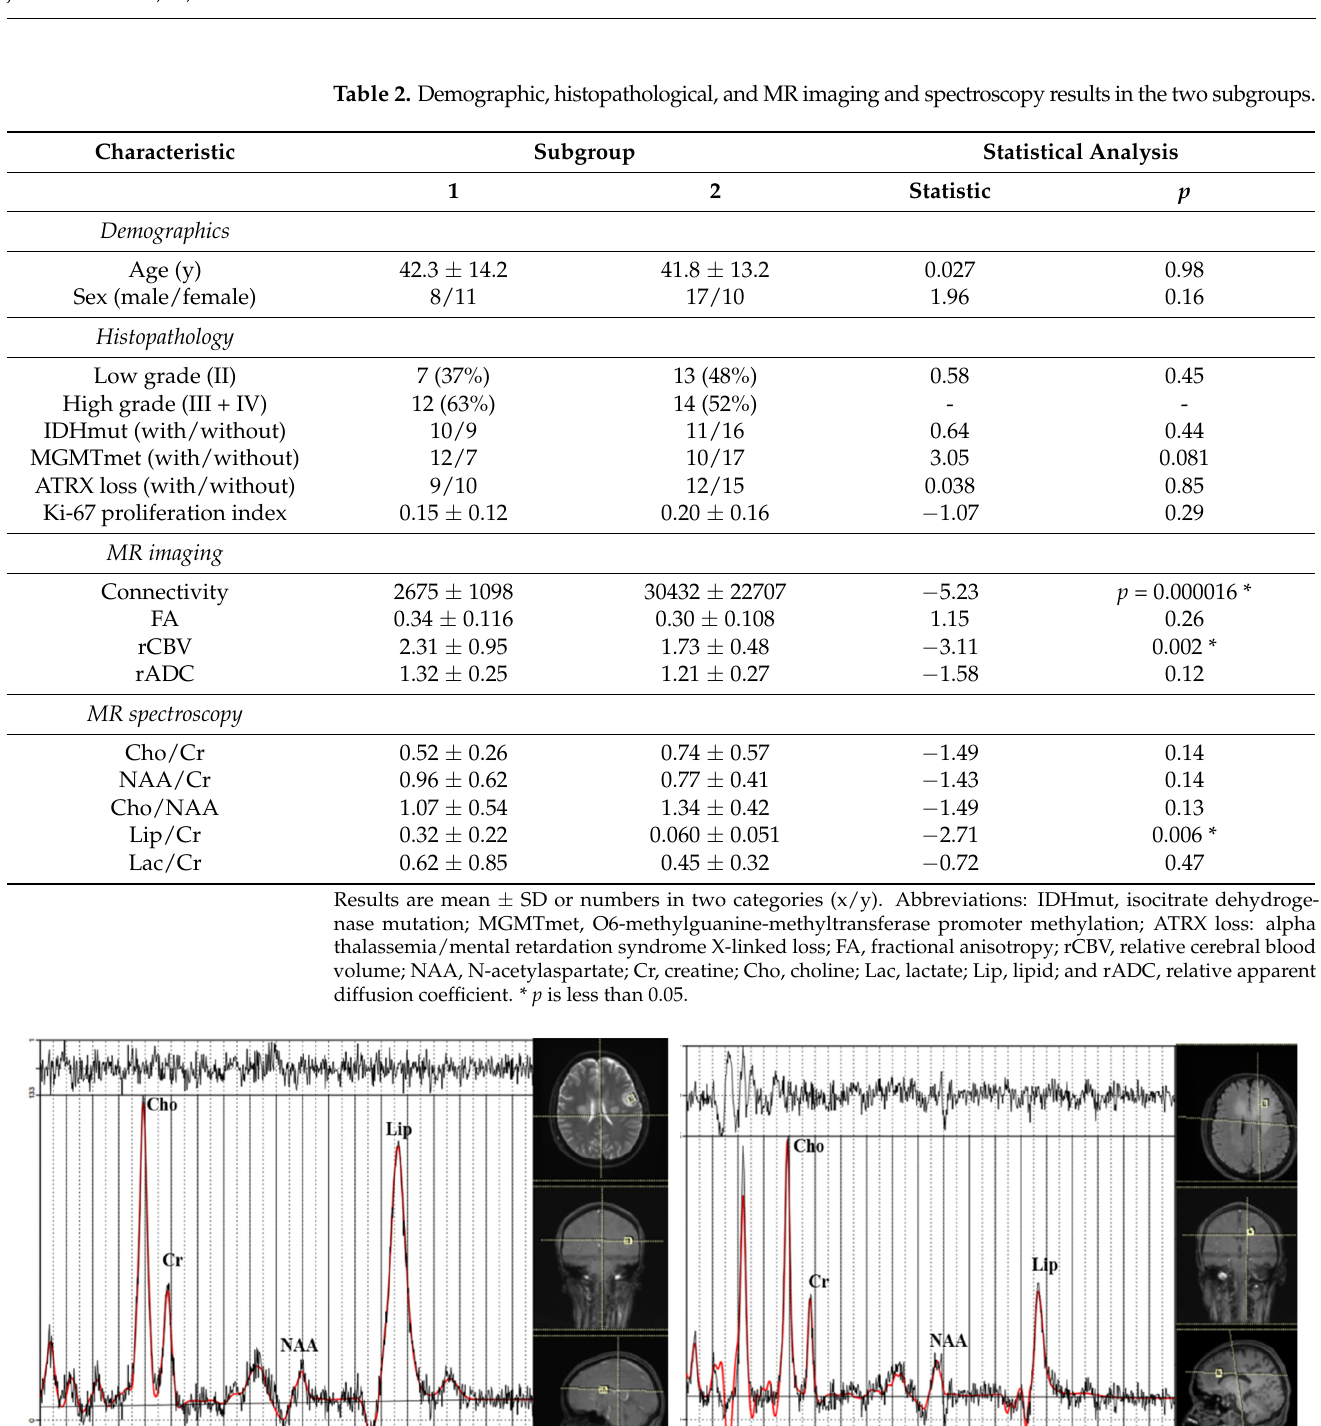
Figure 5. Illustrative cerebral blood volume (CBV) maps from the two subgroups. (( A – D ) (left panel) subgroup 1, ( E – H ) (right panel) subgroup 2). ( A , B ) Enhanced T1-weighted MRI showing 3 neoplastic foci. ( C , D ) CBV map showing elevated CBV at the foci. ( E , F ) Enhanced T1-weighted MRI showing 2 neoplastic foci. ( G , H ) CBV map showing elevated CBV at the foci.